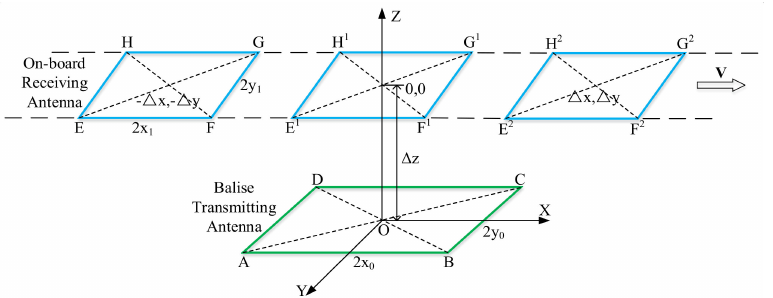
Figure 4. Schematic diagram of mutual inductance model between balise antenna and onboard antenna. Rectangular ABCD is a balise transmitting antenna, and rectangular EFGH is an on- board receiving antenna. A three-dimensional rectangular coordinate system is established, taking the center of the balise transmitting antenna as the origin. It takes the directions parallel to the AB and DA sides of the balise transmitting antenna as the OX axis and the OY axis. Let the direction perpendicular to the balise transmitting antenna be the OZ axis. → V is consistent with the positive direction of the OX The train speed vector